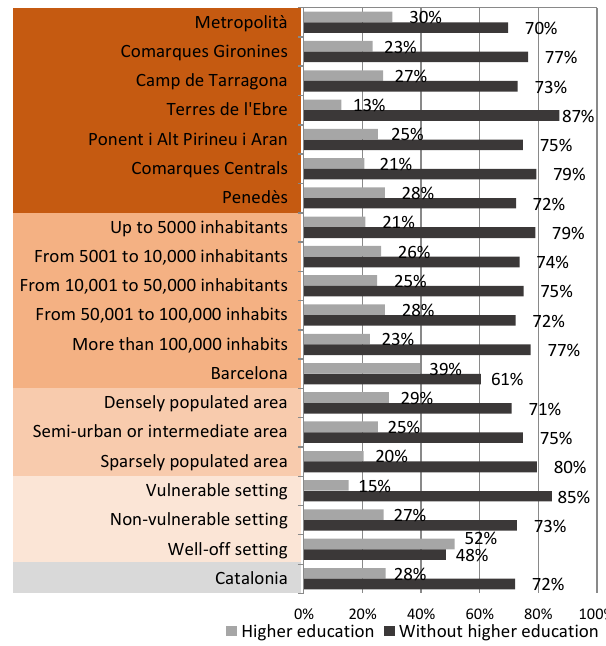
Figure 2. Level of studies attained. Catalonia, population aged 25 years and over. Year 2011. Source: In-house construction based on the ECVHP, 2011.